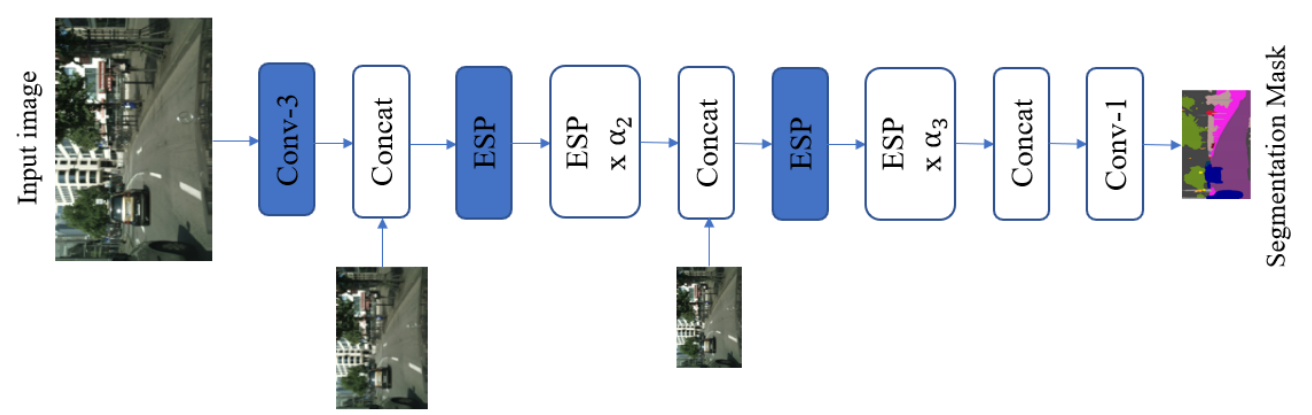
Figure 4. Network structure of